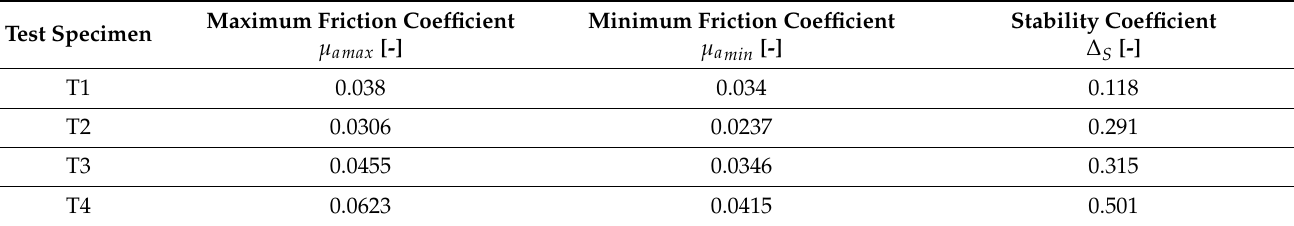
Table 8. Friction coefficient value of friction disks.